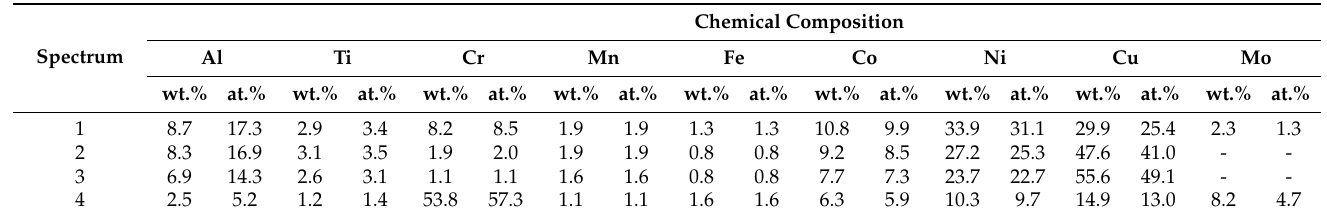
(Figure 10c). Table 2. EDS element concentrations in points indicated on the 15% Ud sample (Figure